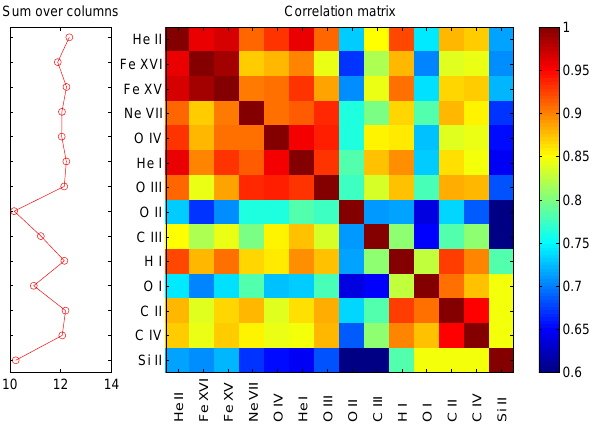
Fig. 9. Correlation matrix of the 14 lines given in Table 1. Correla- tions lower than 0.6 are marked in dark blue and are not considered to be significant. The degree of correlation of a line with all the other ones is obtained by summing along each row of the correla- tion matrix. This sum is displayed in the left.